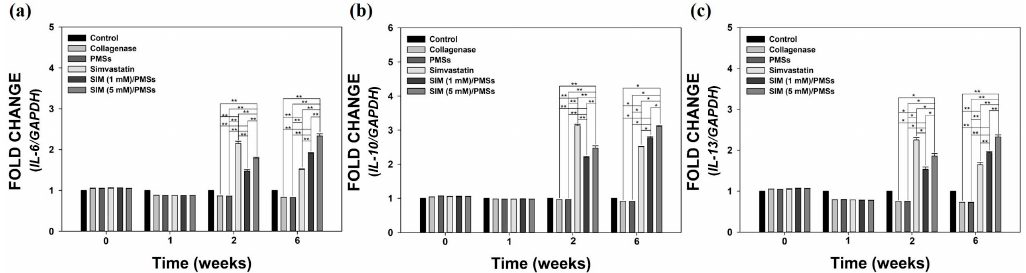
Figure 8. The relative mRNA expression levels of anti-inflammatory cytokines, including: ( a ) IL-4 , ( b ) IL-10 , and ( c ) IL-13 in whole blood samples from the collagenase-induced Achilles tendinitis rat model in each group. Whole blood samples were collected from the rat models in each group at 0, 1, 2, and 6 weeks after treatment with PMSs, simvastatin, SIM (1 mM)/PMSs, and SIM (5 mM)/PMSs. Each mRNA expression level was determined using real time-PCR analysis. Data represent means ± SDs ( n = 4), (* p < 0.05 and ** p < 0.01).